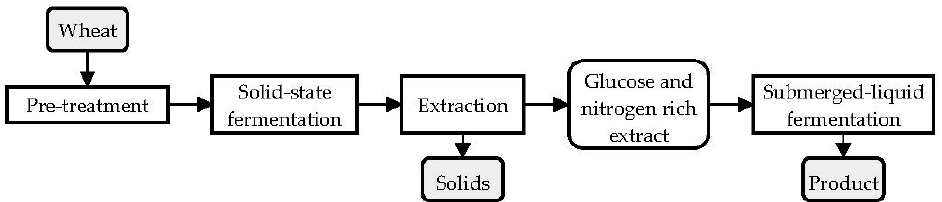
Figure 3. Example of a sequential SsF-SmF proposed in [65] for the production of a generic fermentation feedstock combining solid-state and submerged-liquid fermentations (adapted from [65]).